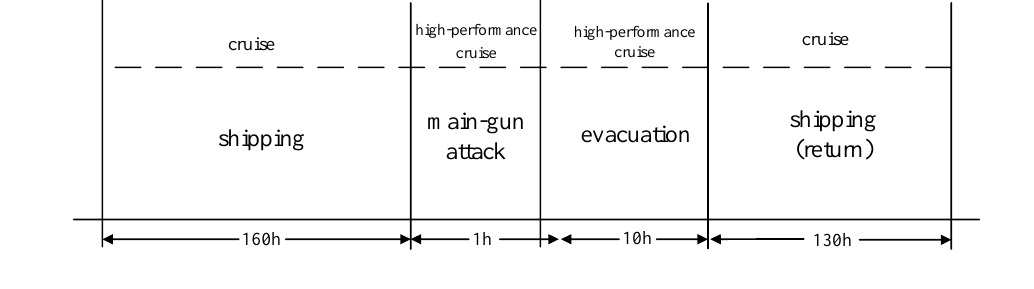
Figure 11. A task flow of a warship. Table 4. Unit task parameter list.